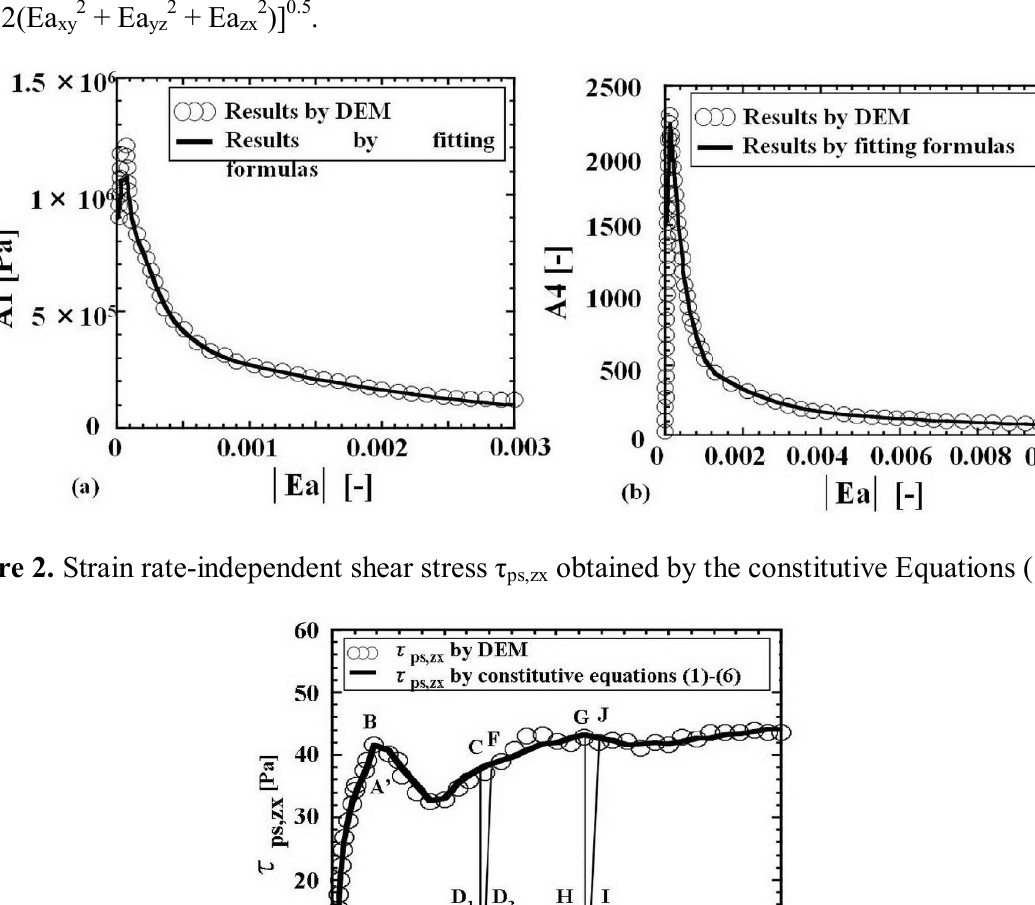
Ea ] 0.5 = [Ea xx2 + Ea yy2 + Ea zz2 ij ij